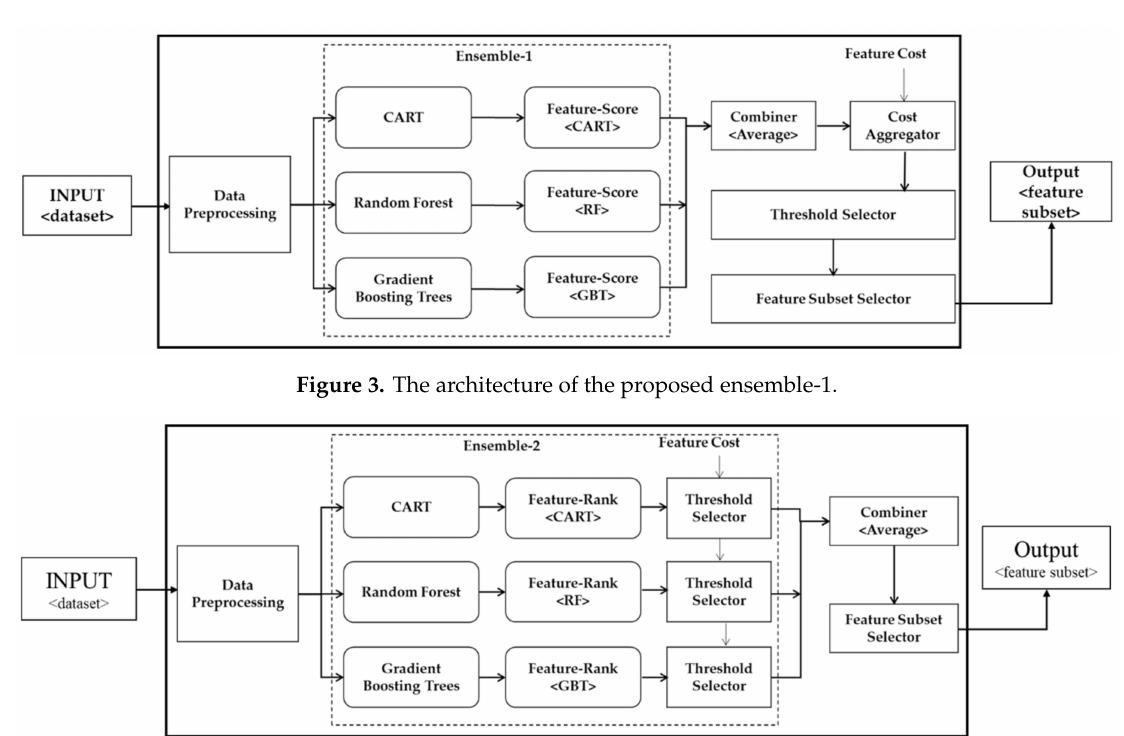
Figure 4. The architecture for the proposed